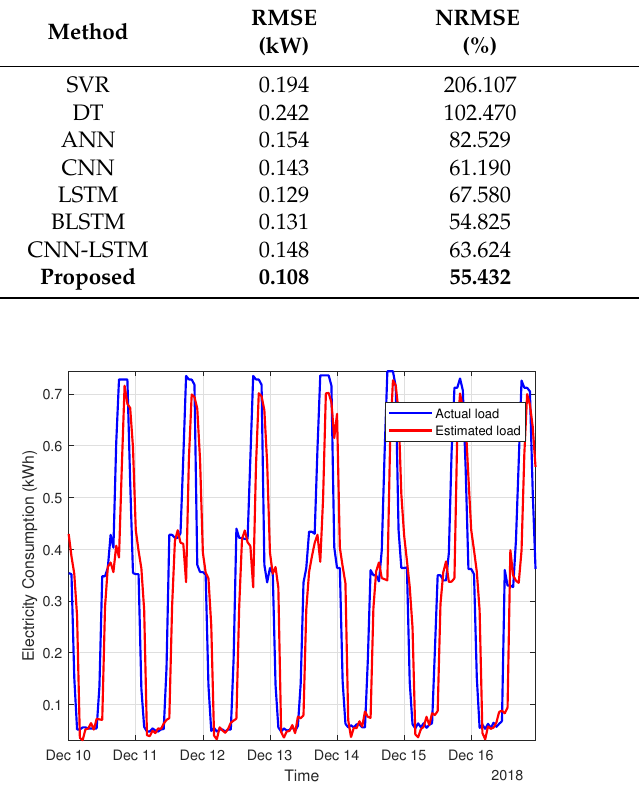
Figure 8. Estimated load profile of a commercial building (customer ID: